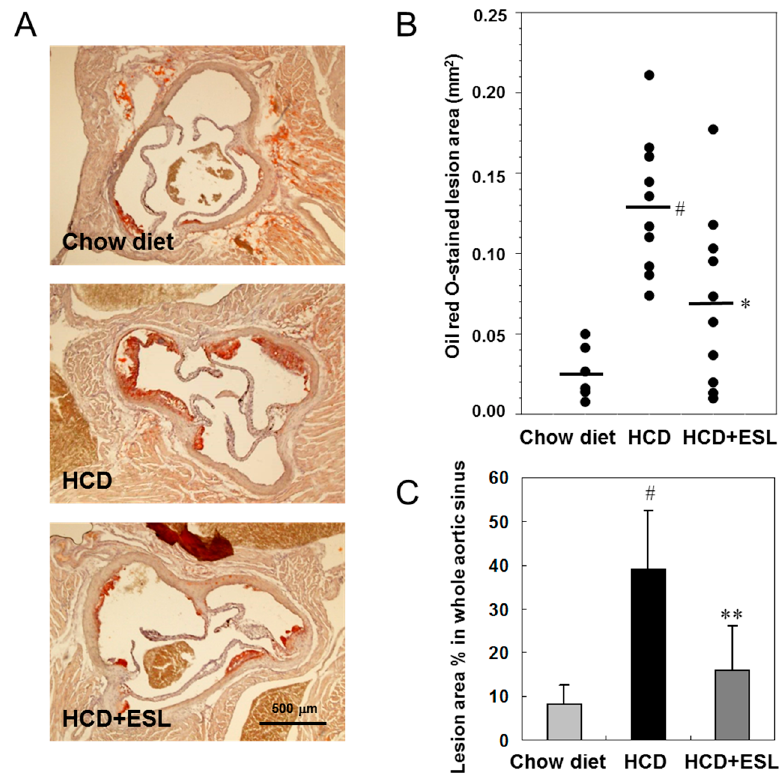
Figure 5. Effects of HCD + ESL on atherosclerotic lesion formation in the aortic sinus of LDLR − / − mice fed a Western diet for 12 weeks: ( A ) representative micrographs of an oil red O-stained cross-section of an aortic sinus (magnification, 40 × ) from each group are shown; ( B ) Quantification of the oil red O-stained aortic sinus lesional areas. Black lines are shown as mean lesion area; and ( C ) the percentage of oil red O-stained lesion areas in the whole aortic sinus from each group was performed by computer-associated morphometry and the results are presented in the graph. The results are shown as mean ± SD. # p < 0.01 vs. the chow diet group. * p < 0.05 and ** p < 0.01 vs. the HCD group. Chow diet, chow-fed group; HCD, high-cholesterol diet-fed group; HCD + ESL, 1% ( wt / wt diet) ESL supplemented HCD-fed group.